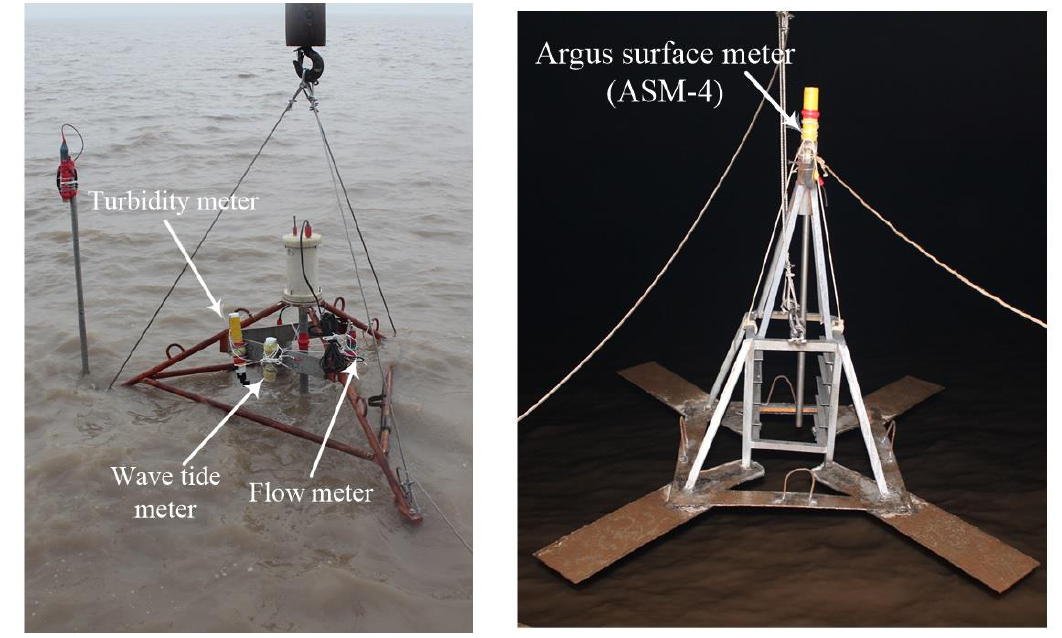
Figure 2. Observation system consisting of a wave–tide gauge (RB16-TWR-2050), ALEC-EM current-velocity meter, XR-420 turbidity meter, and ASM-4.